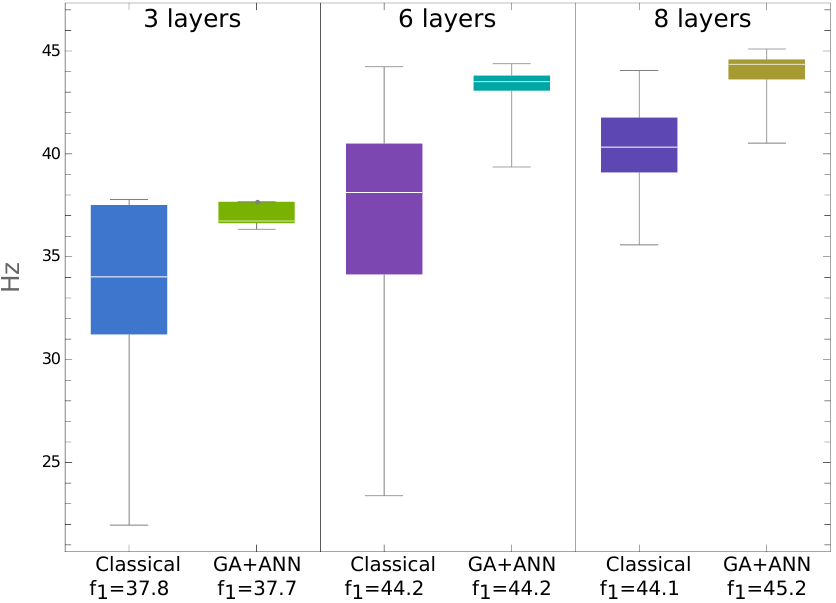
Figure 7. Optimization of f 1 the MODEL1 structure with a different number of layers using classical minimization